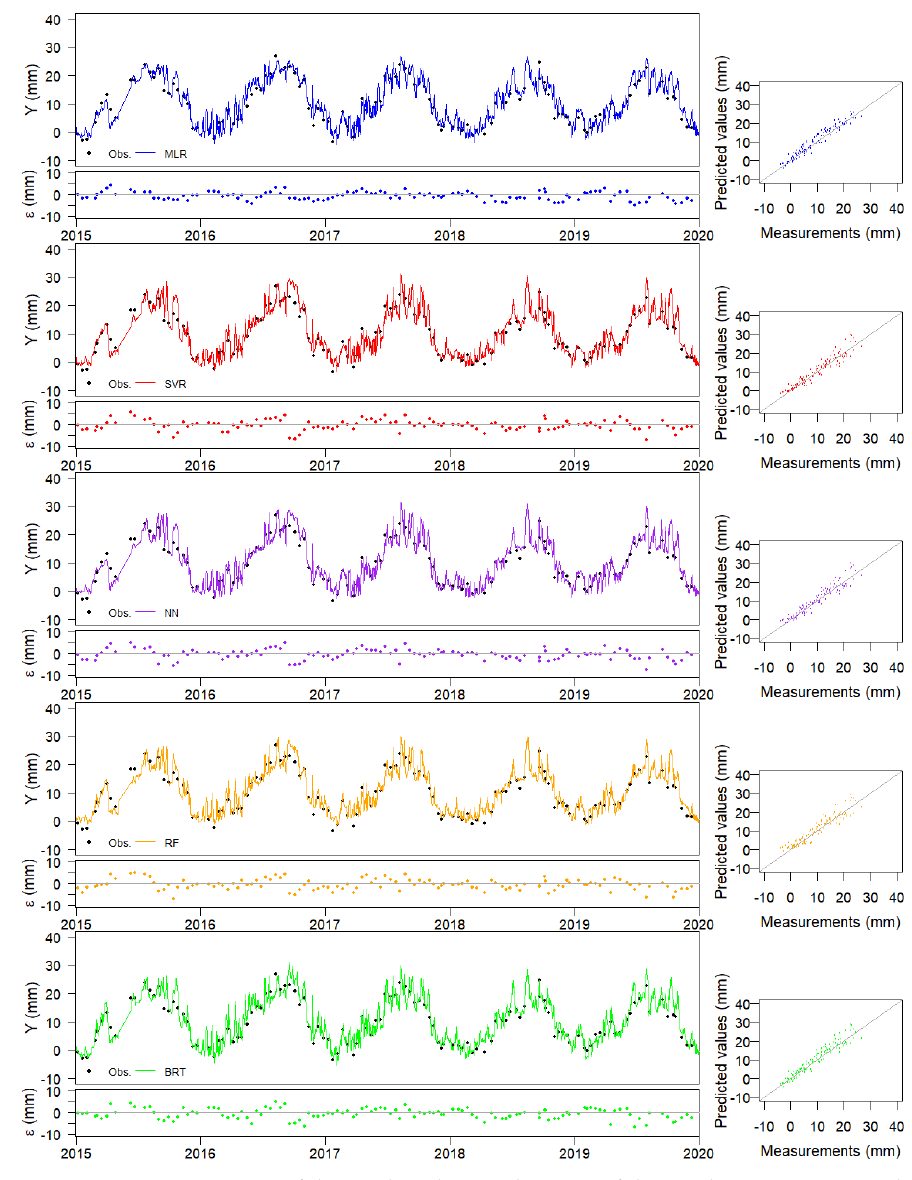
Figure 18. Measurements of the predicted set and output of the Machine Learning models for the horizontal upstream-downstream displacements at FP3/5–277.07 m base, block